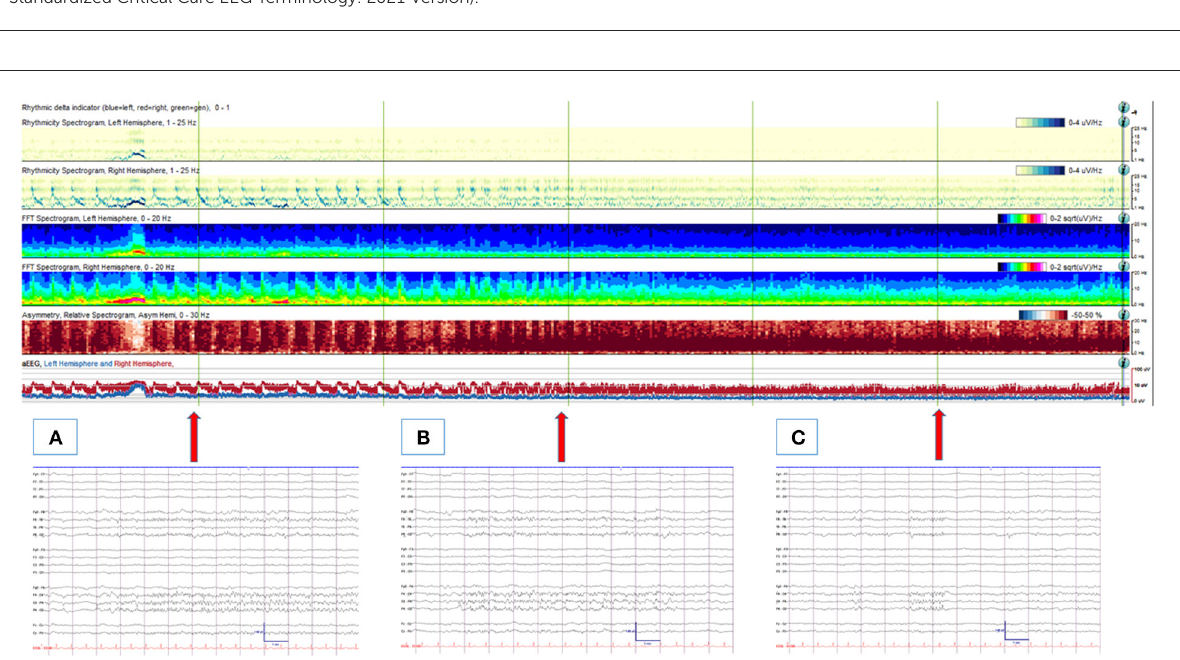
FIGURE1 An 88-year-old man with an acute traumatic brain injury with right sided intraparenchymal hemorrhage, subdural hemorrhage and subarachnoid hemorrhage, who was noted to have frequent left facial twitching. (Upper panel) A quantitative EEG panel showing a total of 1-h duration. From the beginning of the record, frequent cyclic seizures are seen originating from the right hemisphere (with increased rhythmicity, power, asymmetry and amplitude from the right hemisphere with each seizure). With anti-seizure medication treatments, seizures resolve, and no more cyclic seizure patterns are depicted from the quantitative EEG analysis. (Lower panel) corresponding (arrows) raw EEG examples are shown. (A) An electrographic seizure from the right hemisphere (maximal from the parasagittal region). (B) Evolving BIRDs from the same area, lasting 9s. (C) Non-evolving BIRDs from the same area. High- and low-pass filters were set at 1 and 70Hz, respectively. The notch filter was